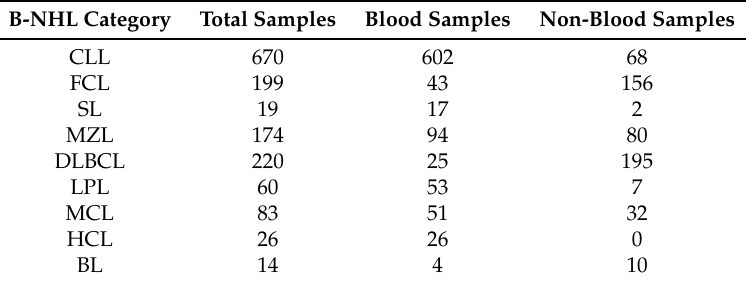
Table 2. Distribution of samples in B-NHL categories. Samples are furtherly divided according to their origin: blood samples (PB/BM) and non-blood samples (lymph nodes and tissue biopsies or FNA, pleural and peritoneal effusions, liquor and bronchoalveolar lavage).